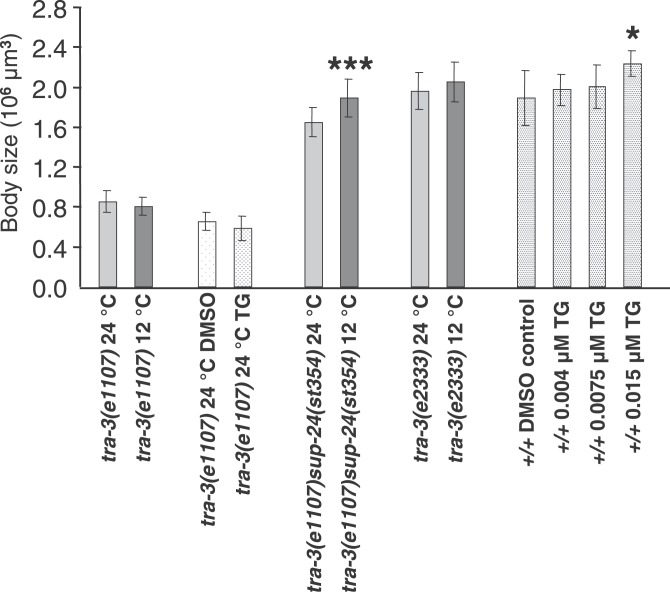
Effect of Temperature and TG on Body Size in C. elegans
We measured body size in the mutants tra-3(e1107) (size of pseudomales is comparable to normal males but smaller than hermaphrodites) exposed to temperature and TG (including DMSO control). Also shown are the body sizes of the suppressed tra-3 mutant tra-3(e1107)sup-24(st354)IV, and tra-3(e2333) exposed to temperature, and wild-type N2 (+/+) exposed to TG and DMSO control. * = significant at 0.01 < p < 0.05 and *** = significant at p < 0.001. Bars are standard deviation. +/+:F
(1,28) = 5.25, CB:F
(1,47) = 0.67, tra-3(e1107):F
(1,38) = 1.43, tra-3(e1107) 24 °C DMSO versus TG:F
(1,14) = 1.77, tra-3(e1107)sup-24(st354) F
(1,22) = 14.44, tra-3(e2333):F
(1,27) = 1.52, and +/+ 24 °C DMSO versus TG:F
(1,8) = 6.65.